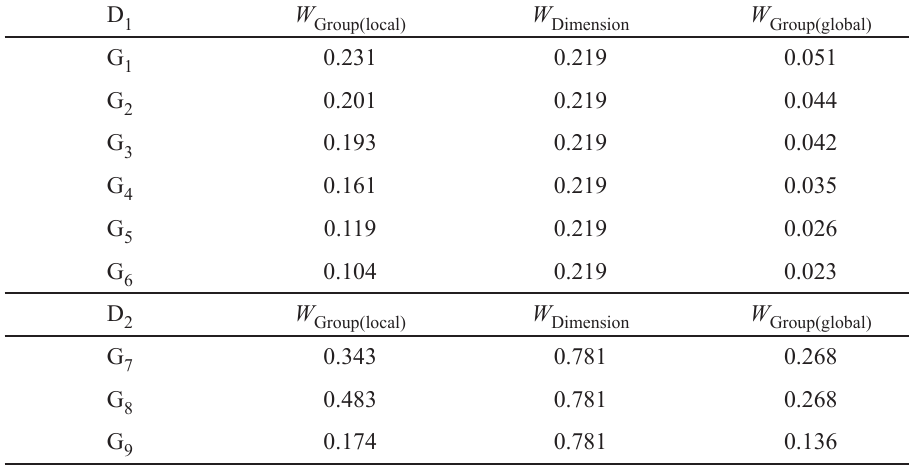
Table 4. The global weight for each group